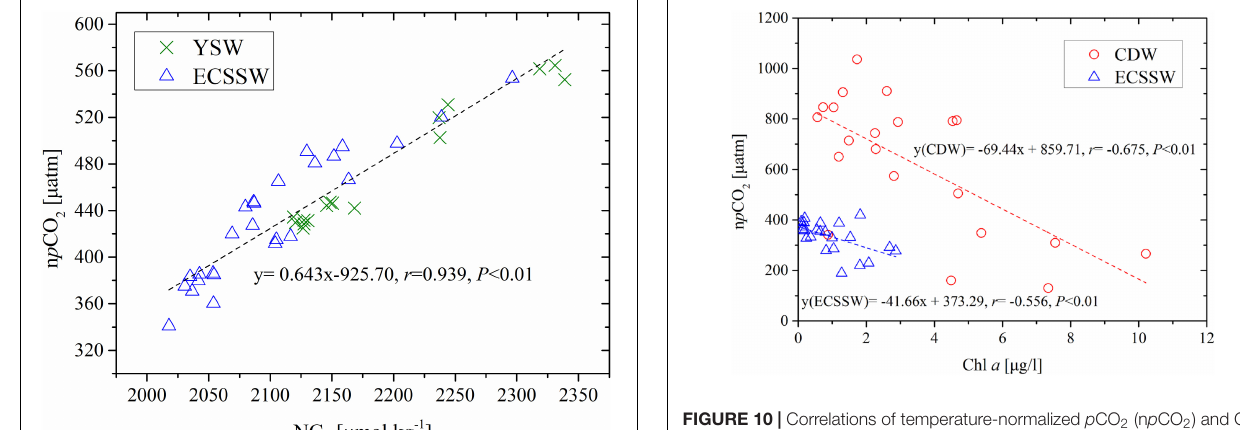
FIGURE 10 | Correlations of temperature-normalized p CO 2 (n p CO 2 ) and Chl a of YSW and ECSSW in July. The n p CO 2 was normalized to an average temperature of 26.55 ◦ C.